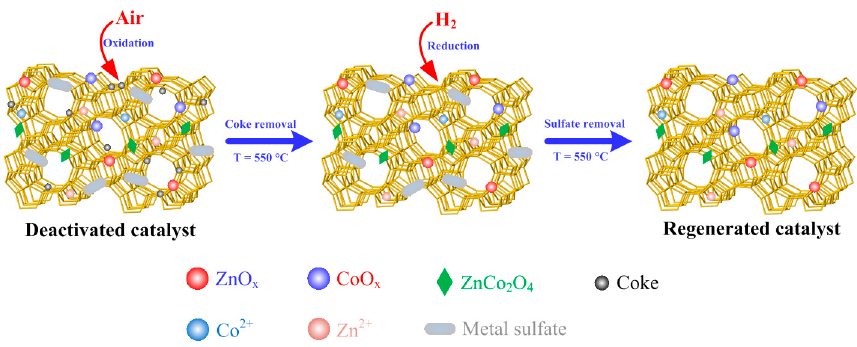
Scheme 1. Regeneration pathway for the combined polluted Co ‐ Zn/H ‐ Beta catalyst.